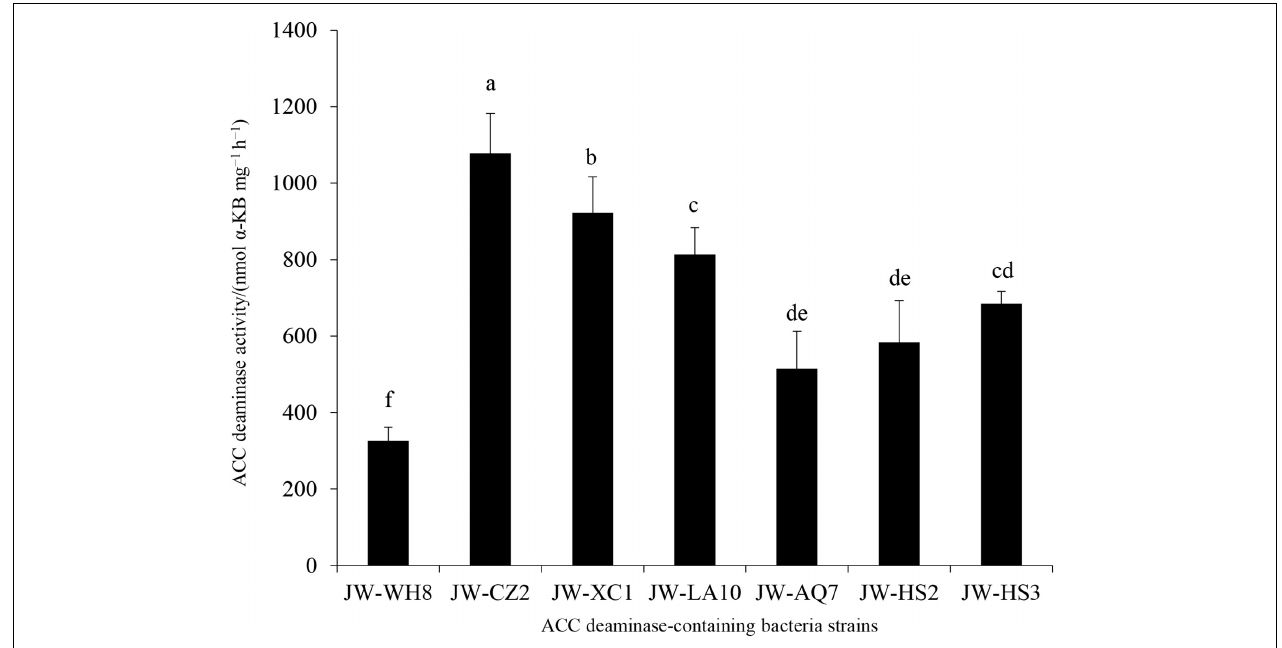
FIGURE 1 | ACC deaminase activities of seven isolates from rhizosphere soil of C. sinensis . Data represent mean and SD ( n = 3). Different letters indicate statistically significant differences ( p <